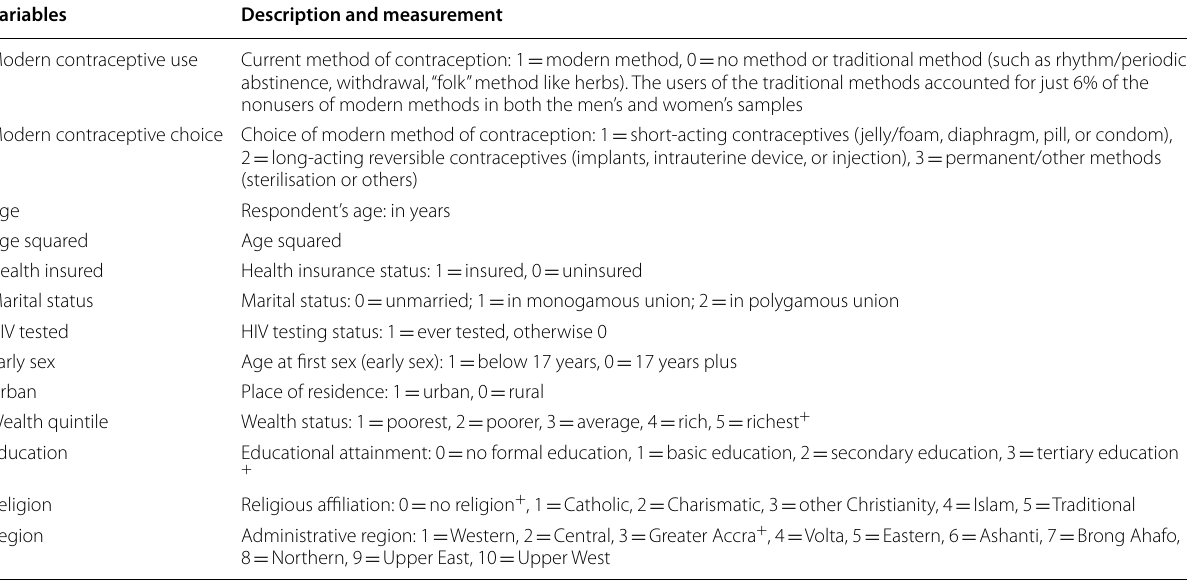
Sample weights and clusters applied in the mean and standard error estimations, (